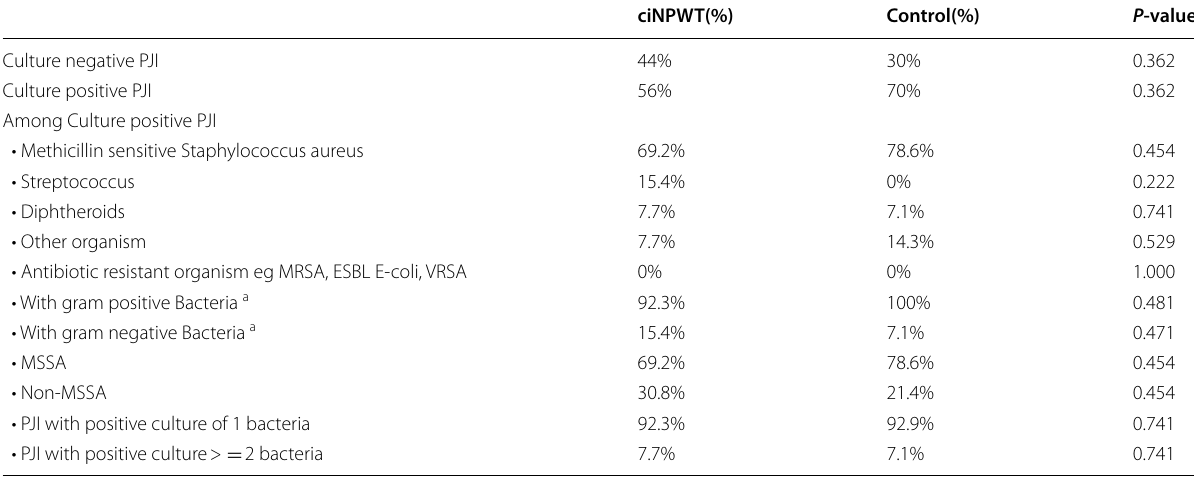
Table 3 Comparison of bacteriology of PJI cases in the